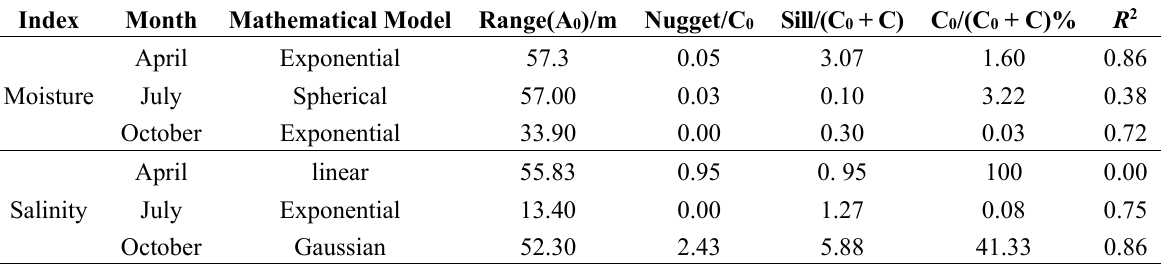
Figure 6. Variograms of soil moisture and EC among different seasons. Table 3. Parameters of semivariogram models for soil moisture and salt among different